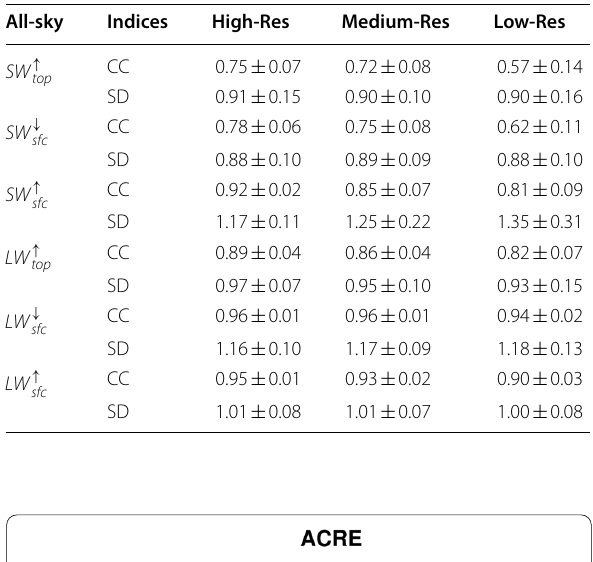
Table 2 A summary of correlation coefficient (CC) and normalized standard deviation (SD) for three different groups of CMIP6 models, with high‑resolution, medium‑resolution and low‑resolution groups, respectively